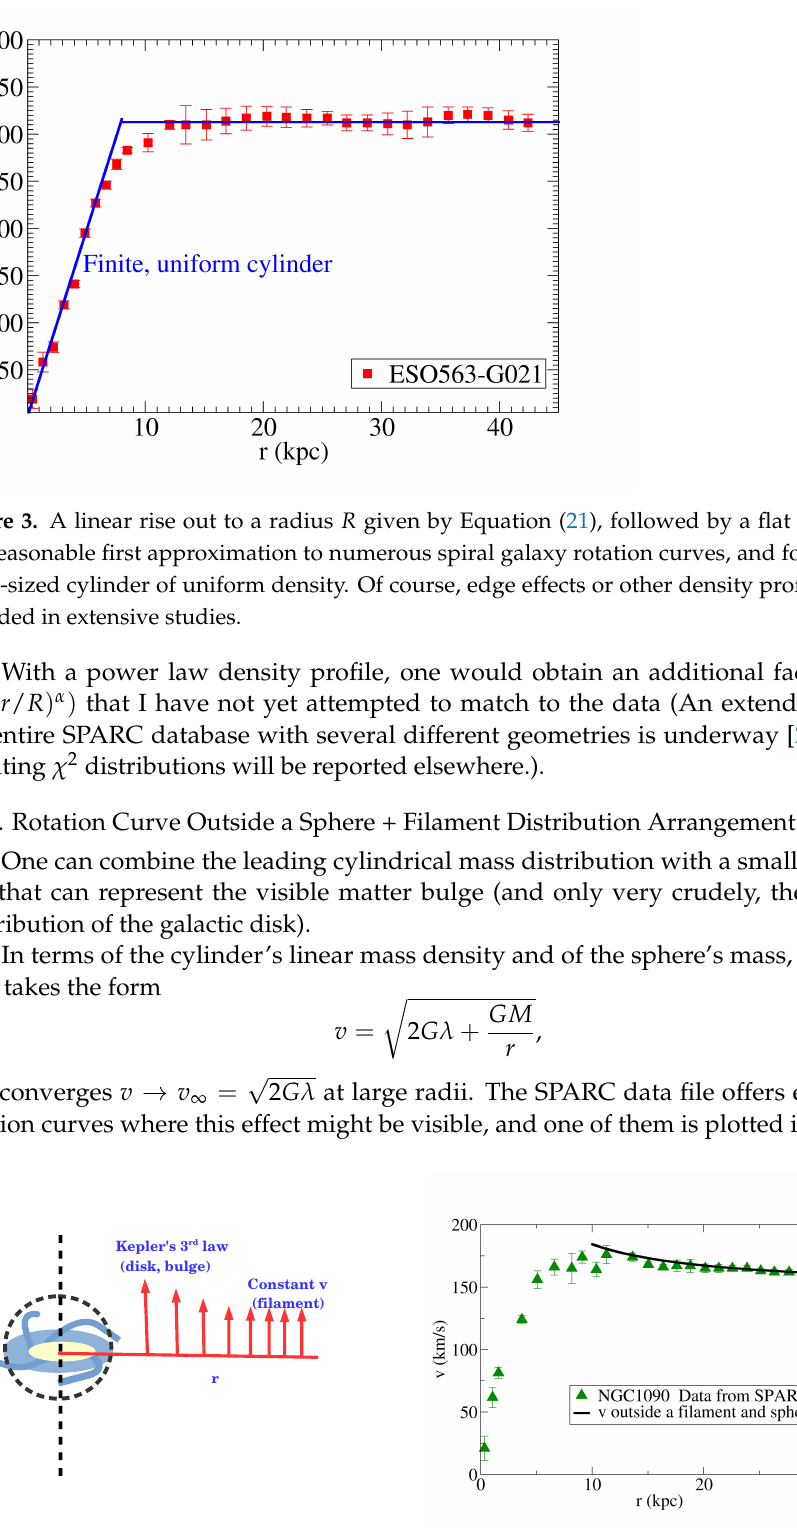
Figure 4. Left : Scheme showing how the velocity falls towards the asymptotic limit given by the filament alone, as the contribution of the sphere becomes smaller as per Kepler’s third law. Right : An example galaxy curve extracted off the SPARC database where the effect might be